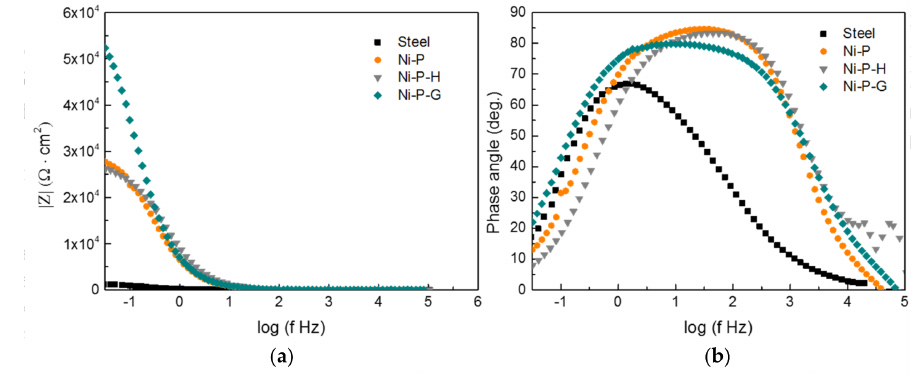
Figure 5. Bode plots of the Q235 steel, Ni–P, Ni–P–H, and Ni–P–G at the immersion time of 2 h in 3.5 wt % NaCl solution: ( a ) frequency-impedance magnitude curves; ( b ) frequency-phase angle